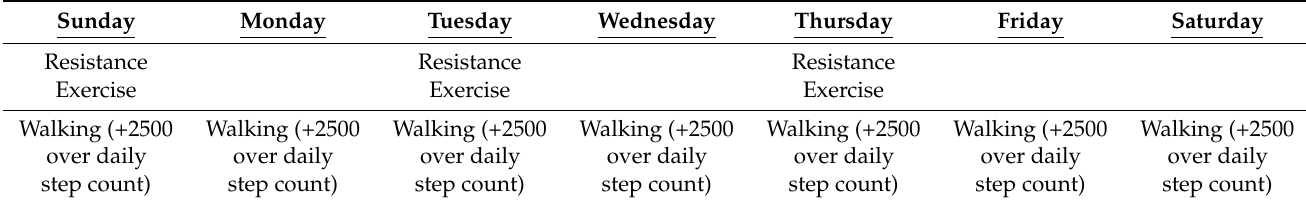
Table 2. Example Training